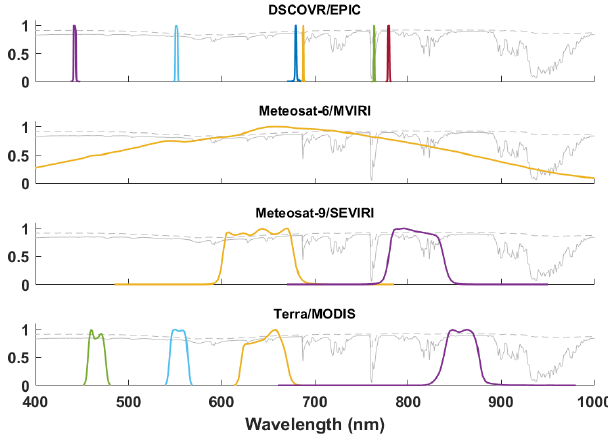
Figure 3. Colored lines: spectral response functions of different sensors in the spectral range considered by Heliosat-V. Gray lines: TOA reflectance spectra of typical scenes with a high- (dashed line) and low-altitude (solid line) thick